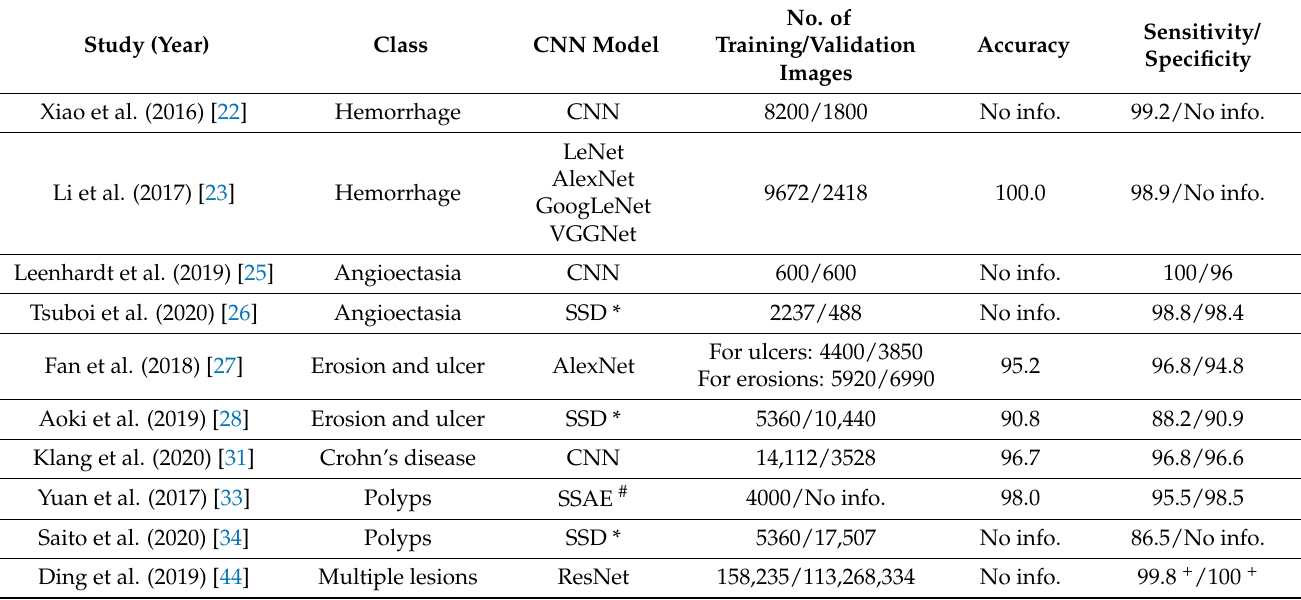
Table 2. State of the art deep learning-based methods for wireless capsule